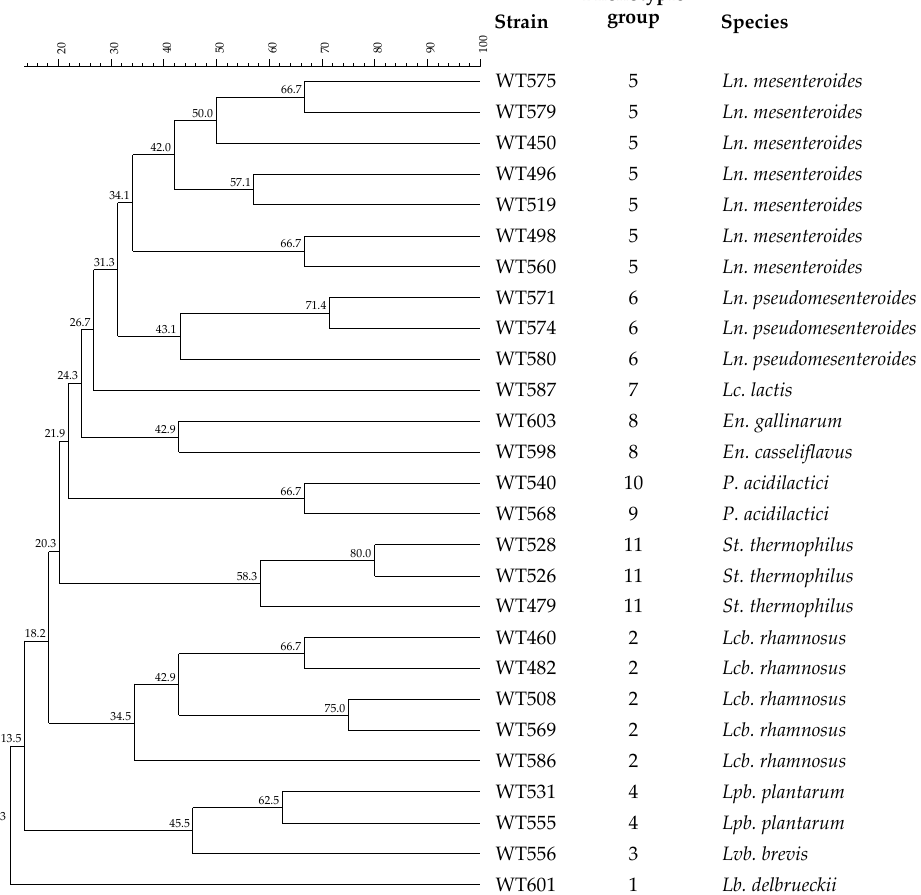
Table 4. Distribution of LAB species among wooden tables. LAB Species